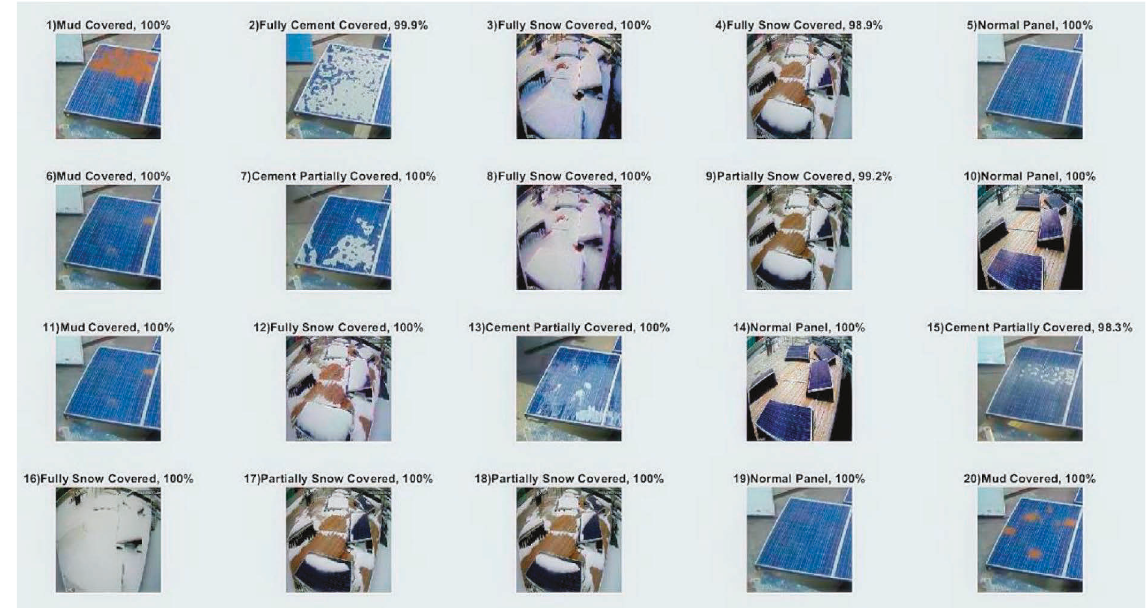
Figure 16: Fault classified by SqueezeNet with testing accuracy.